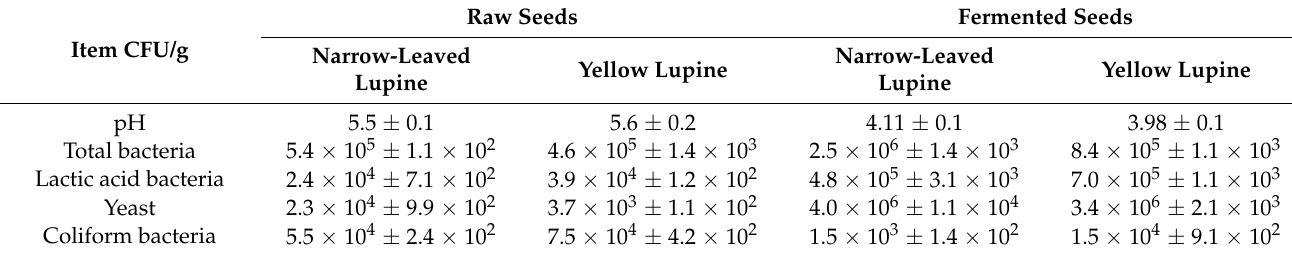
Table 2. The microbial status of raw and fermented lupine